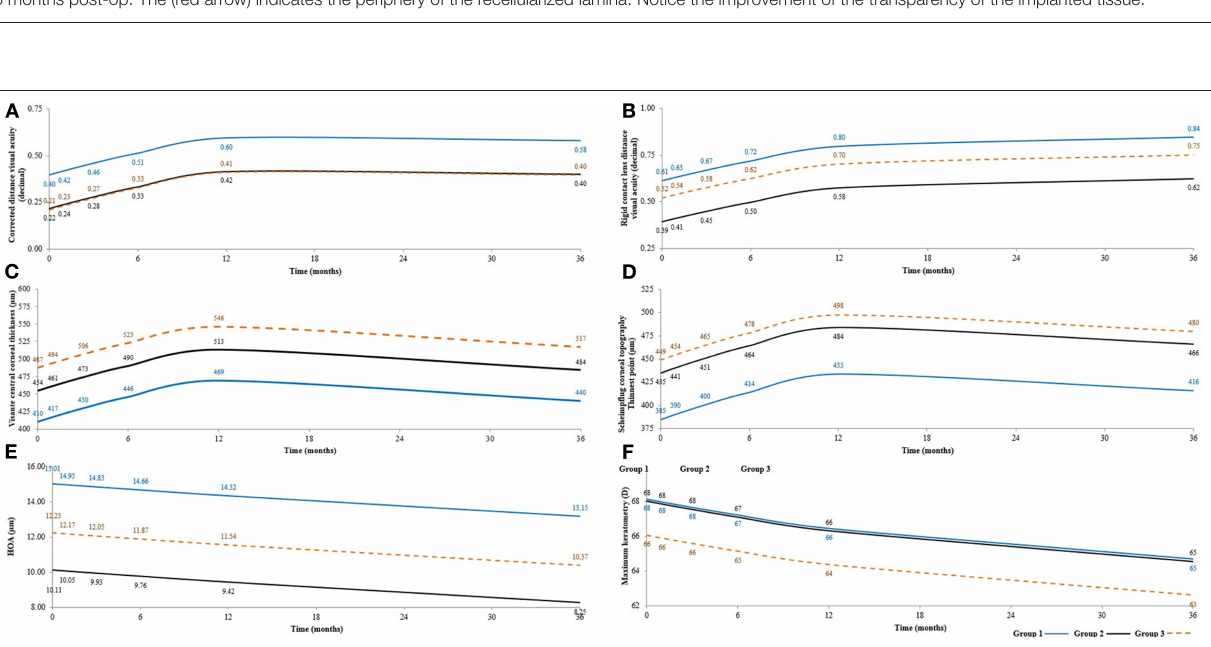
FIGURE 2 | Biomicroscopic changes between the preoperative up to 36 months post-operative. (A) G-1, case 4, OS, shows the transparency of the cornea in the preoperative. (B) G-1, case 4, shows the transparency of the cornea. The presence of a peripheral surgical scar (red arrow) at 1month post-op can be noticed. (C) G-1, case 4, shows the stability of the peripheral scaring (red arrow) in the cornea at 12 months post-op. (D) G-1, case 4, shows the transparency of the cornea at 36 months post-op. (E) G-2, case 9, OD, shows the presence of a slight paracentral scar( red arrows) at the pre-operative. (F) G-2, case 9, 12 months post-op, observe the improvement in the transparency of the implanted lamina, (red arrow) represent the periphery of the lamina. (G) G-2, case 9, 36 months post-op, notice the marked improvement in the transparency of the lamina, the periphery of the sheet becomes not very marked (red arrow). (H) G-3, case 12, OD, shows the transparency of the cornea in the preoperative. (I) G-3, case 12, 12 months post-op. The (red arrow) indicates the implanted recellularized lamina. (J) G-3, case 12, 36 months post-op. The (red arrow) indicates the periphery of the recellularized lamina. Notice the improvement of the transparency of the implanted